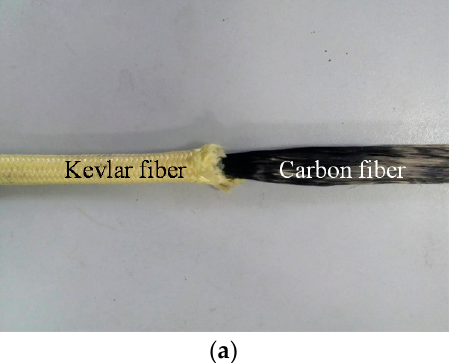
( c ) Figure 3. Pictures of pull-out test site: ( a ) Specimen with implanted CFR; ( b ) Tension clamp; ( c ) Failure characteristics of